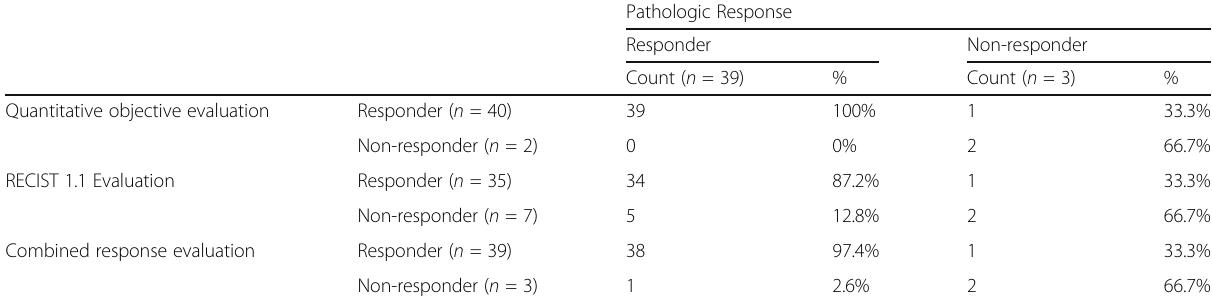
Table 6 Comparison between the numbers of patients classified as responders/non-responders using each of the three evaluations versus pathology base Miller – Payne